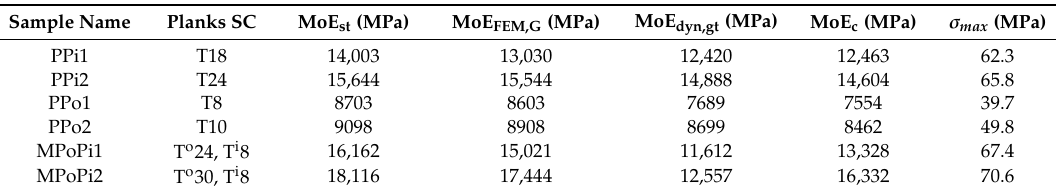
Table 2. Strength grading for the tested samples according to the different modulus of elasticity. MoE st : static modulus of elasticity. MoE dyn,gt : dynamic modulus of elasticity. MoE c : semi-anaytical modulus of elasticity. PPi: single-species pine. PPo: single-species poplar. MPoPi: mixed poplar/pine. T o : Outer planks. T i : Inner planks.